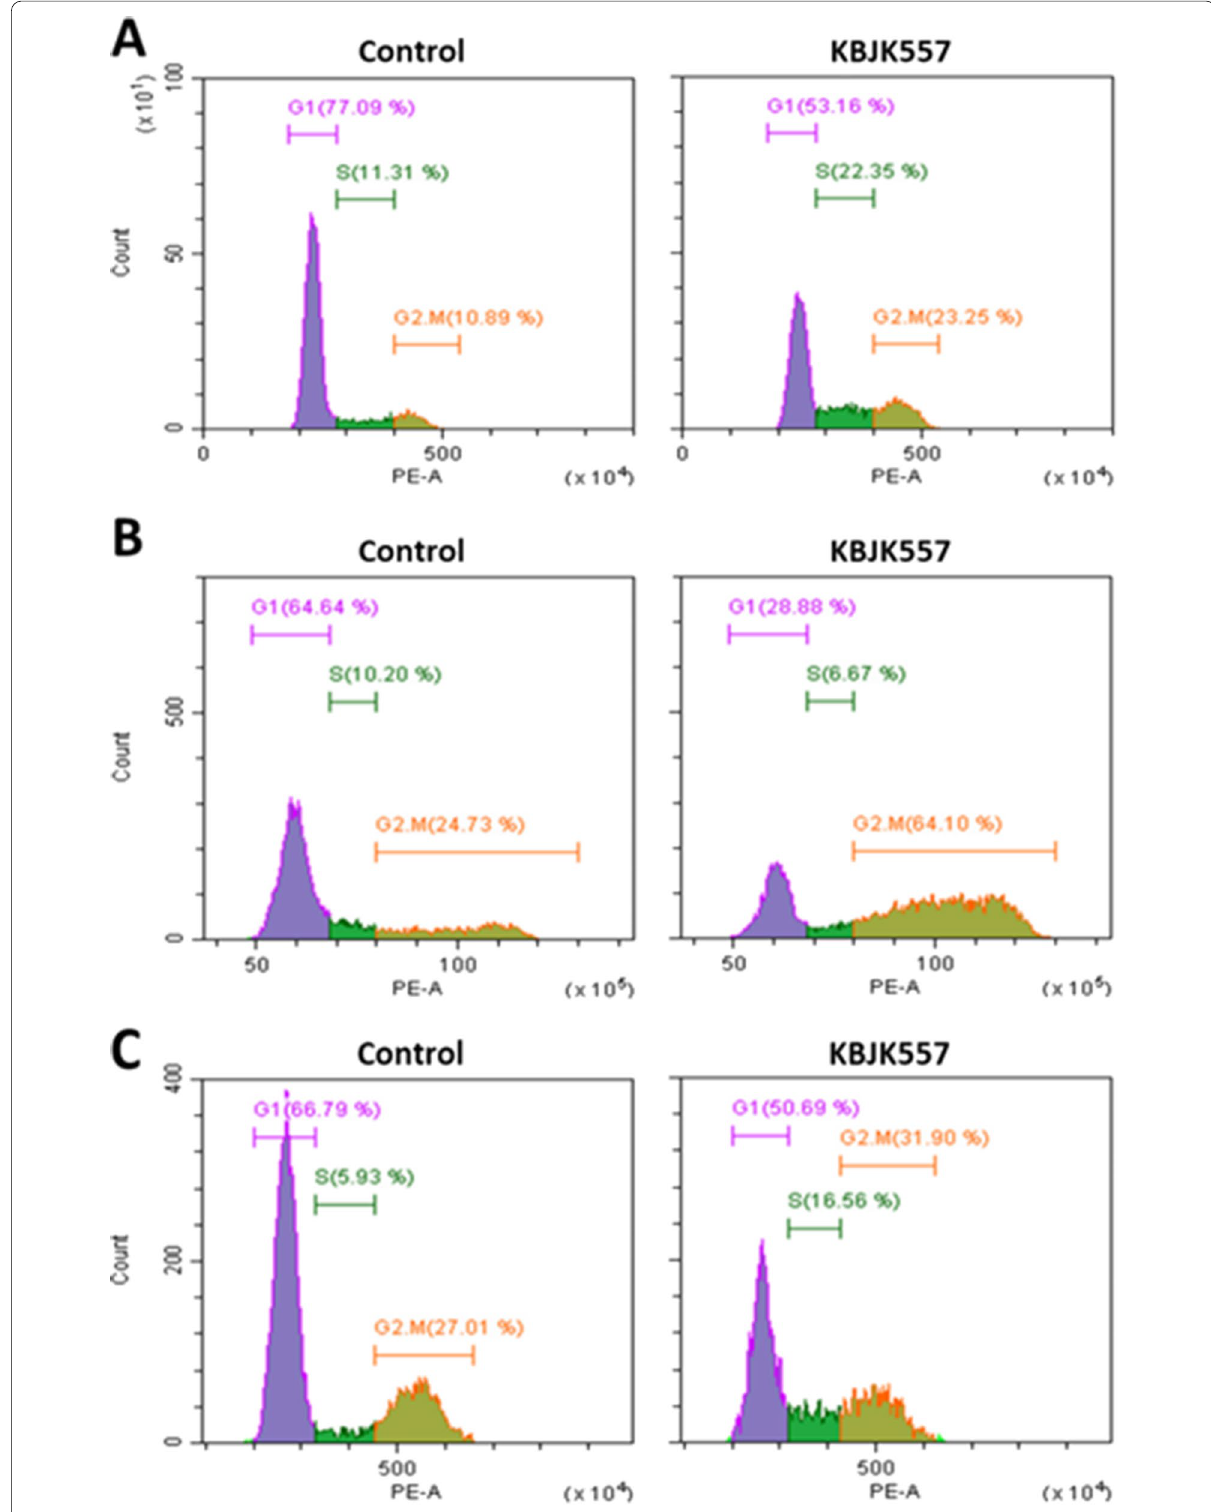
Fig. 2 Fluorescence‑activated cell sorting analysis of cell cycle arrest in non‑small cell lung cancer cells after incubation with KBJK557 for 24 h. Cell cycle arrest was measured by flow cytometry with PI staining. A A549 cells. B PC9 cells. C H1975